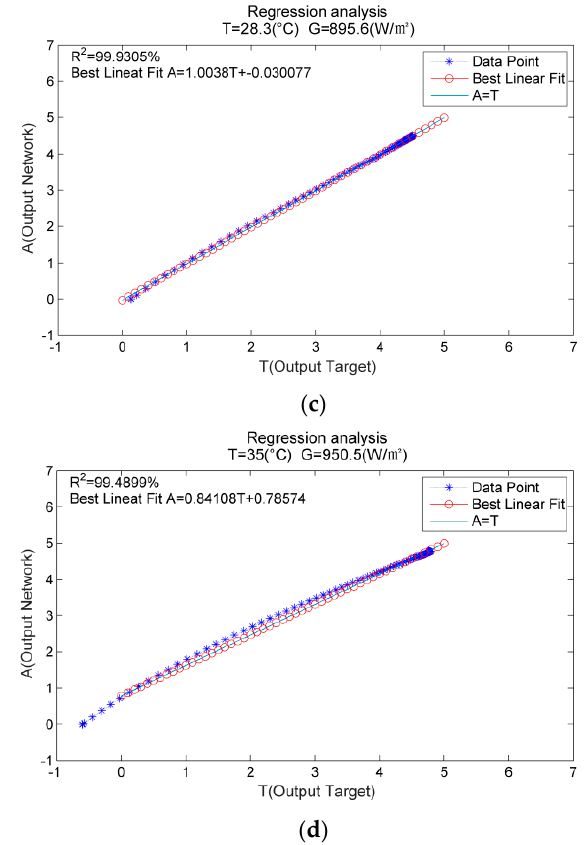
Figure 5. Regression analysis results corresponding to different temperatures and irradiances ( a ) T = 10.1 °C, G = 595.9 W/m 2 ; ( b ) T = 16 °C, G = 483.9 W/m 2 ; ( c ) T = 28.3 °C, G = 895.6 W/m 2 ; ( d ) T = 35 °C, G = 950.5 W/m 2 . Table 2. MSE, MBE, and parameters of regression analysis for measured and predicted curves.